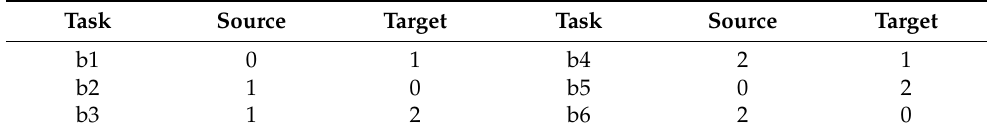
Table 3. The transfer task settings in the CWRU